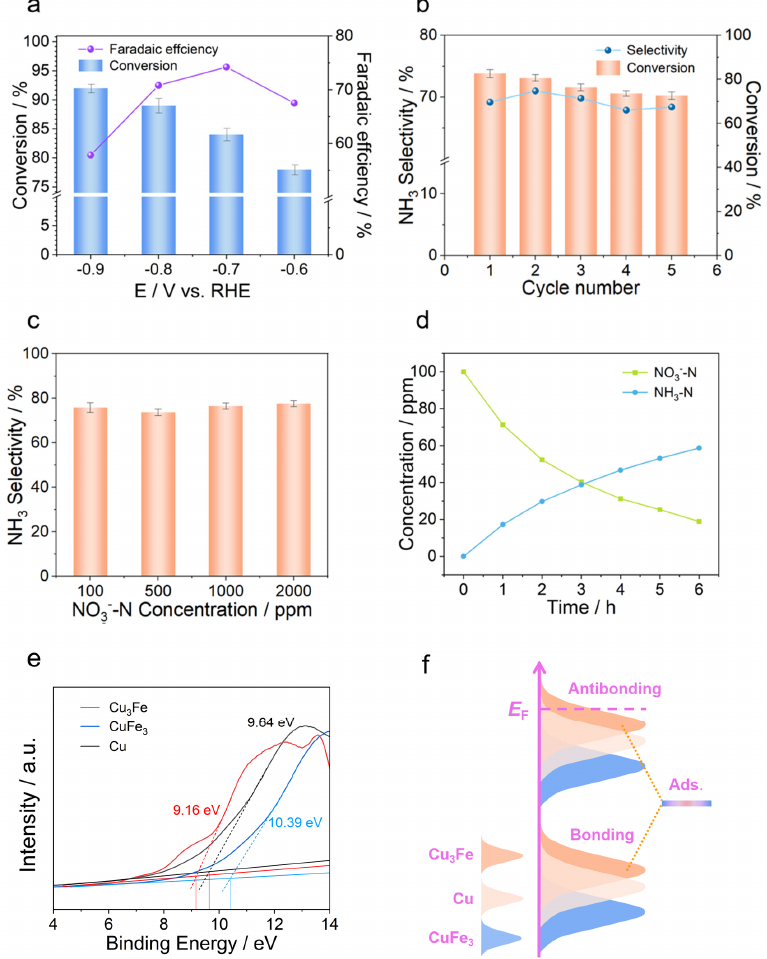
Figure 4. ( a ) Potential-dependent Faradaic efficiency of ammonia and conversion rate of nitrate over Cu 3 Fe. ( b ) The consecutive recycling test at − 0.7 V vs. RHE over Cu 3 Fe cathode. ( c ) Selectivity of ammonia with different concentrations of nitrate over Cu 3 Fe at − 0.7 V vs. RHE. ( d ) The time-de- pendent concentration changes of NO 3 − and ammonia over Cu 3 Fe at − 0.7 V vs. RHE. ( e ) The ultravi- olet photoelectron spectroscopy (UPS) plots of Cu 3 Fe, CuFe 3 and Cu. ( f ) Schematic illustration of bond orbital variation between the catalysts with different Cu/Fe ratios and the adsorbates (Ads.). According to the high-Resolution Transmission Electron Microscope (HRTEM) re- sults (Figure 1b), the Cu (111) plane of Cu 3 Fe nanoalloy exhibited a relatively larger lattice